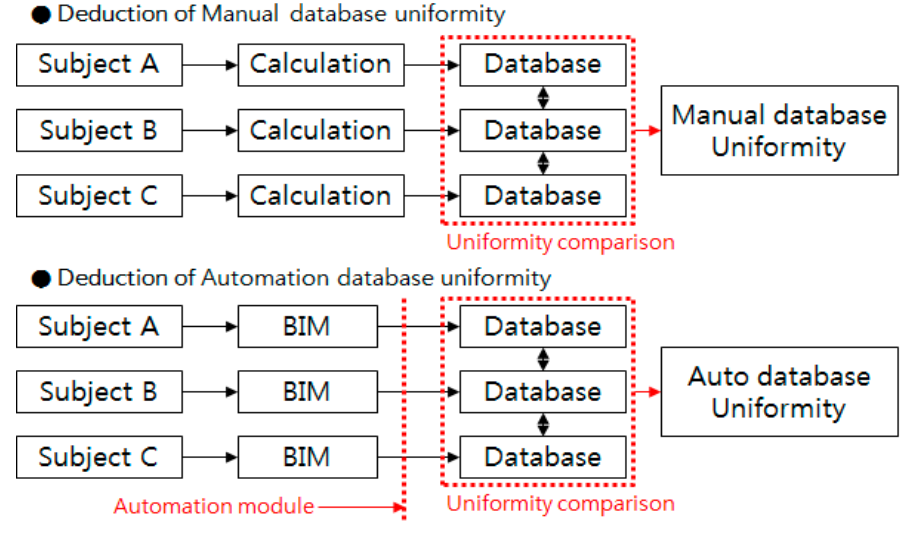
Figure 6. Deduction of database uniformity.